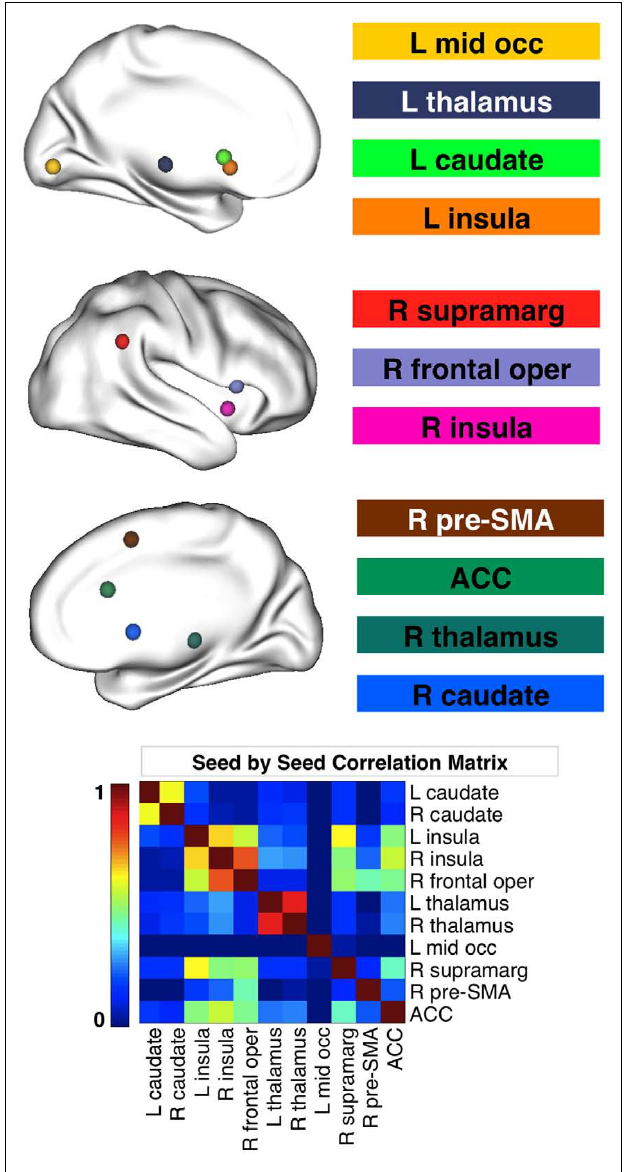
FIGURE 1 | Seed ROI used for functional connectivity analyses. The 11 seed regions were derived from Boehler et al. (2010) and are based on a conjunction analysis that assessed inhibitory control in the stop signal task (SST).The matrix at the bottom of the figure illustrates the seed by seed correlations for the typically developing children in our study.There was no effect of diagnosis on the seed by seed correlations, nor were the correlations related to the SST performance measures. R, right; L, left; mid occ, middle occipital gyrus; supramarg, supramarginal gyrus; pre-SMA, pre-supplementary motor area; ACC, anterior cingulate cortex.